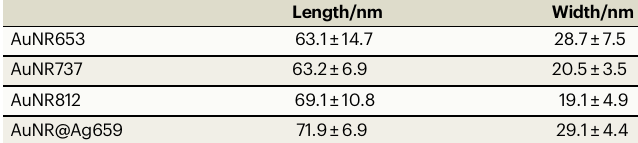
Table 1 | Size statistics of different plasmonic